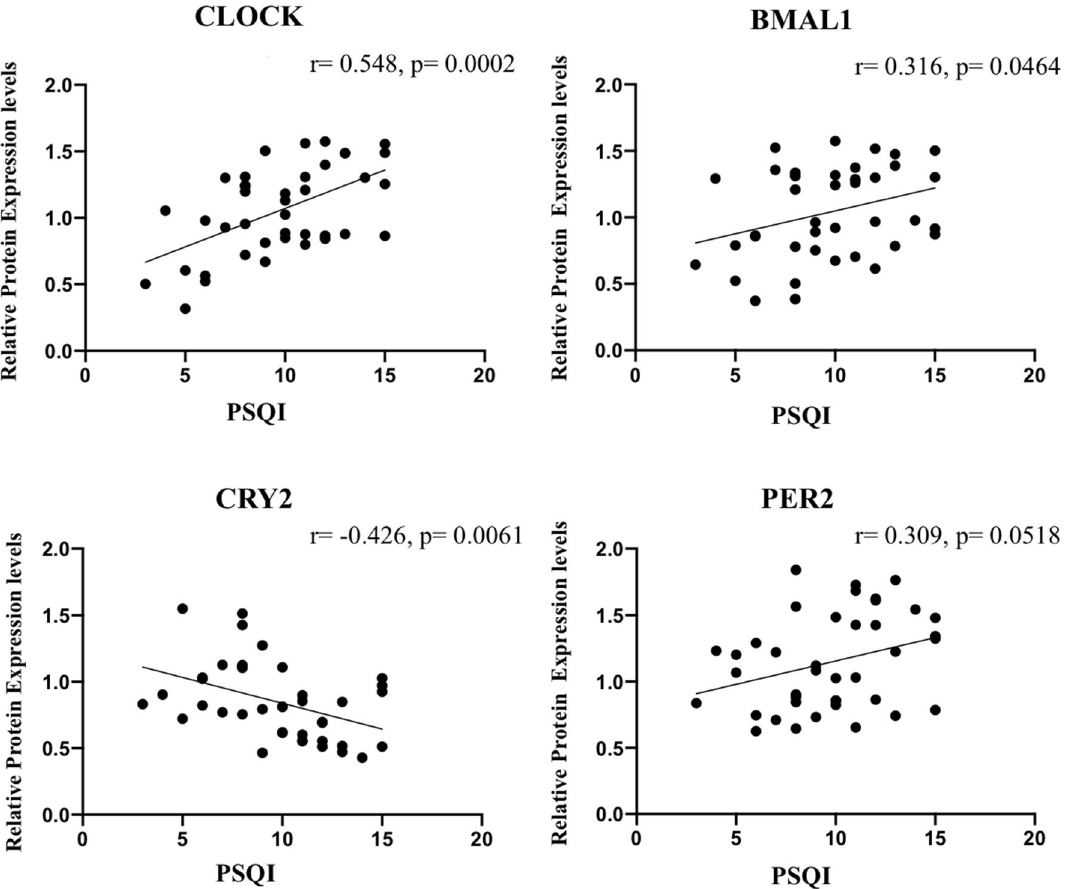
Figure 6. The relationship between PSQI of 40 thyroid nodule patients and the relative protein expression levels of CLOCK, BMAL1, CRY2 and